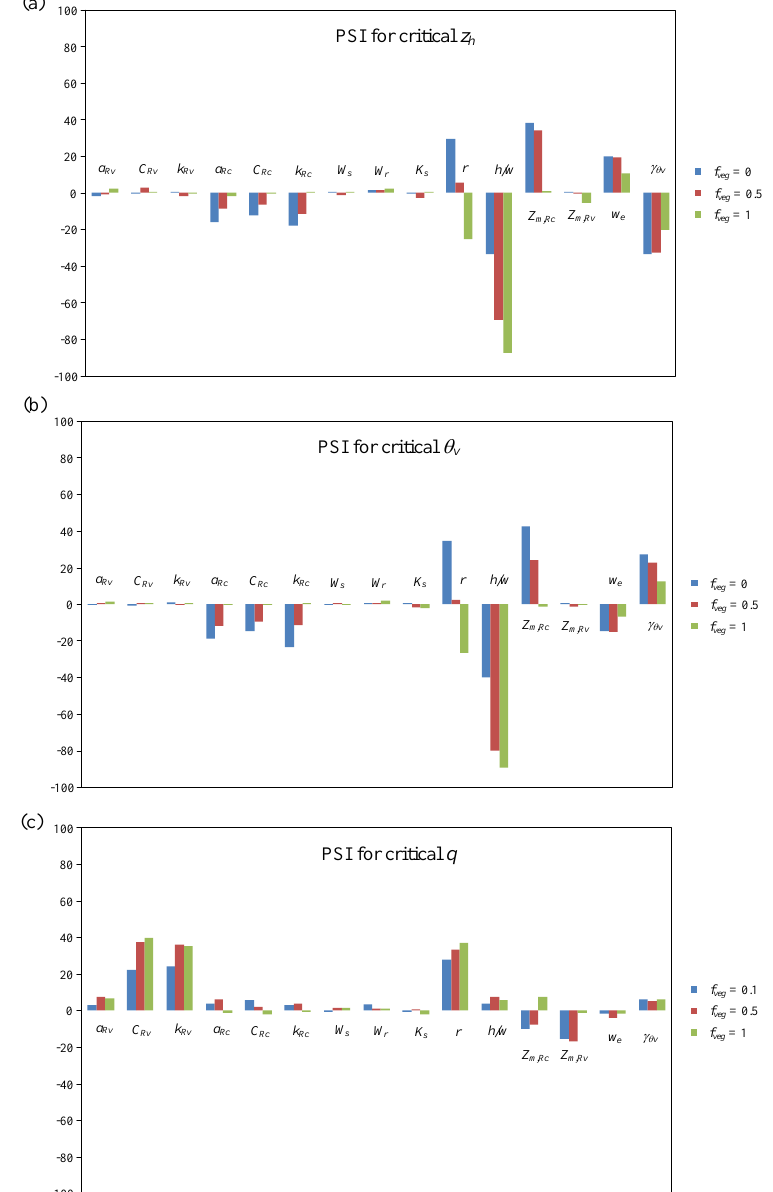
Figure 8. PSI values for model outputs of critical (a) z h , (b) mixed layer θ v , and (c) mixed layer q , with different green roof